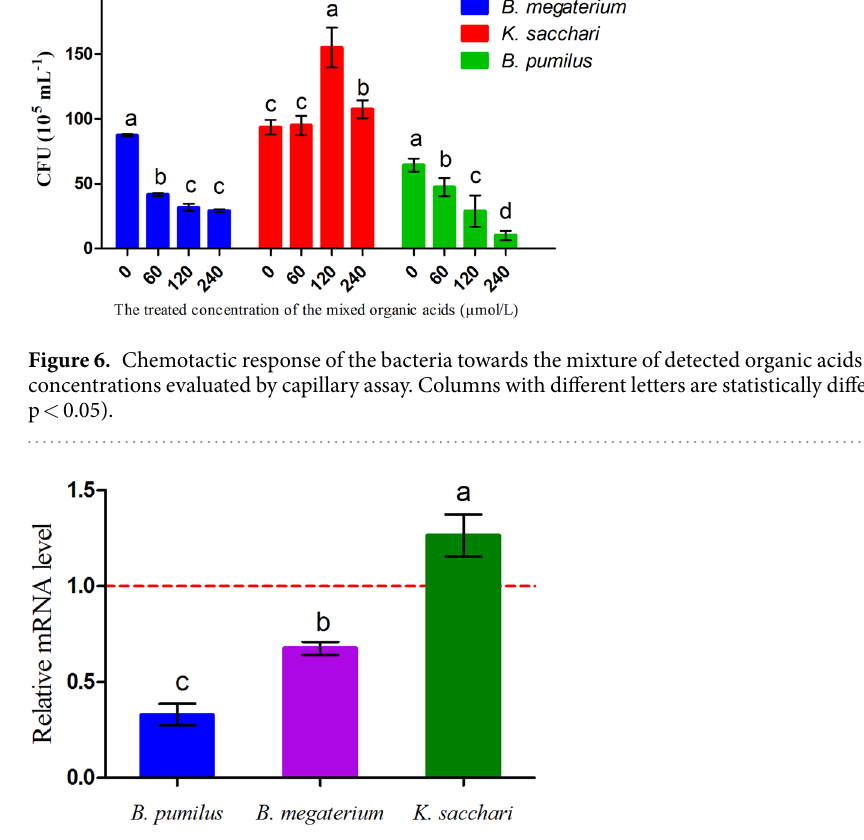
Figure 7. The effects of the mixed organic acids on the che A gene transcription in the studied bacteria. Columns with different letters are statistically different (LSD test, p < 0.05).